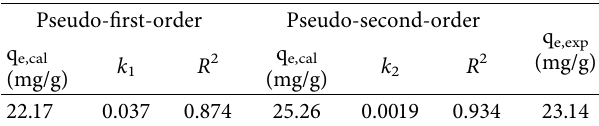
Table 3: Calculated kinetic parameters of models for RhB ad- sorption onto CAC/CoFe 2 O 4 200.